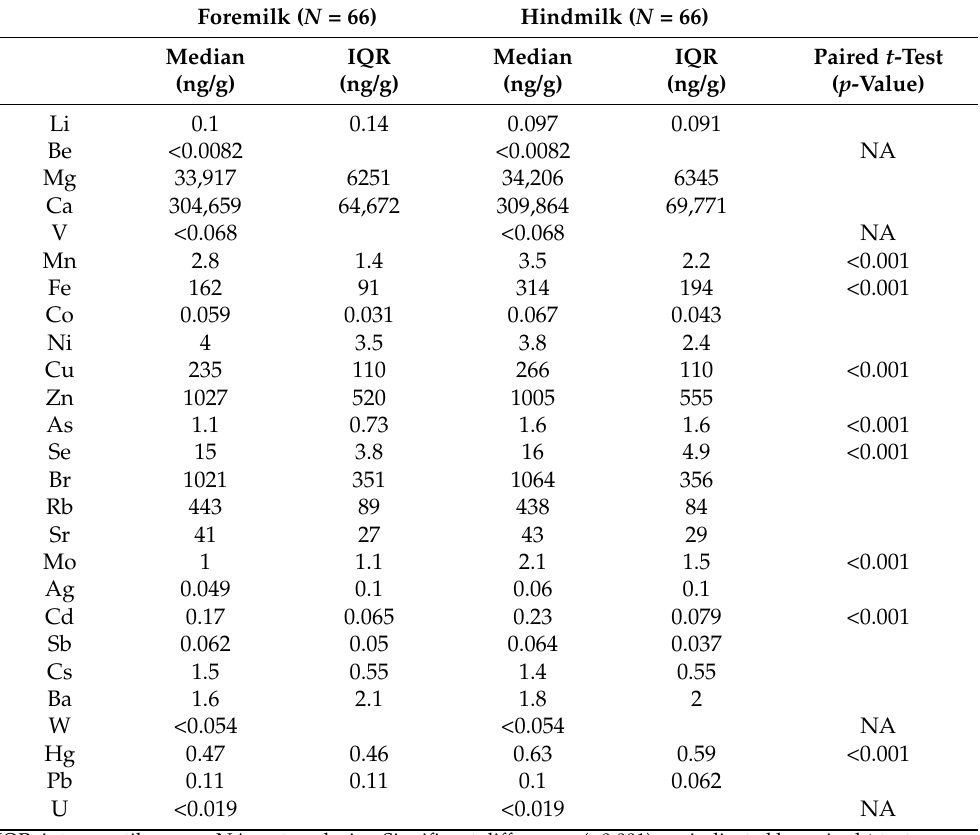
Table 6. Difference in elements between fore- and hindmilk.